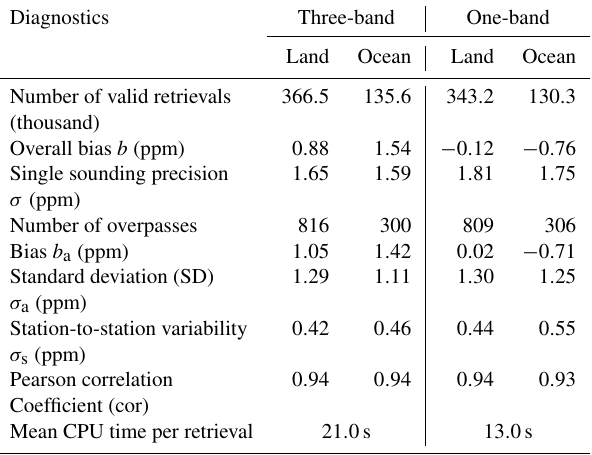
Table 3. Overall performance of three-band and one-band retrievals. Here, overall bias and single sounding precision are estimated for single soundings. All other quantities are obtained using overpass- averaged values.